Question: Write a caption explaining this figure to a reader.
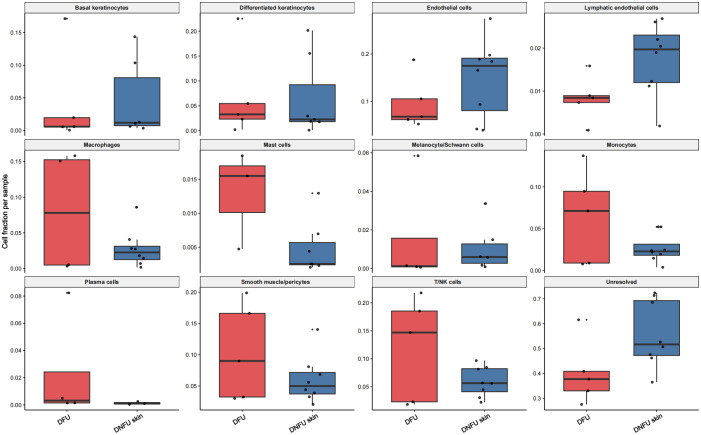
Answer: Sample-level cell-composition comparison between DFU and DNFU skin. Box plots show per-sample cell fractions for each annotated cell population across 13 samples (5 DFU and 8 DNFU skin samples). Each point represents one sample. Group comparisons were performed between DFU and DNFU skin at the sample level using two-sided Wilcoxon rank-sum tests, followed by Benjamini-Hochberg false-discovery-rate correction.